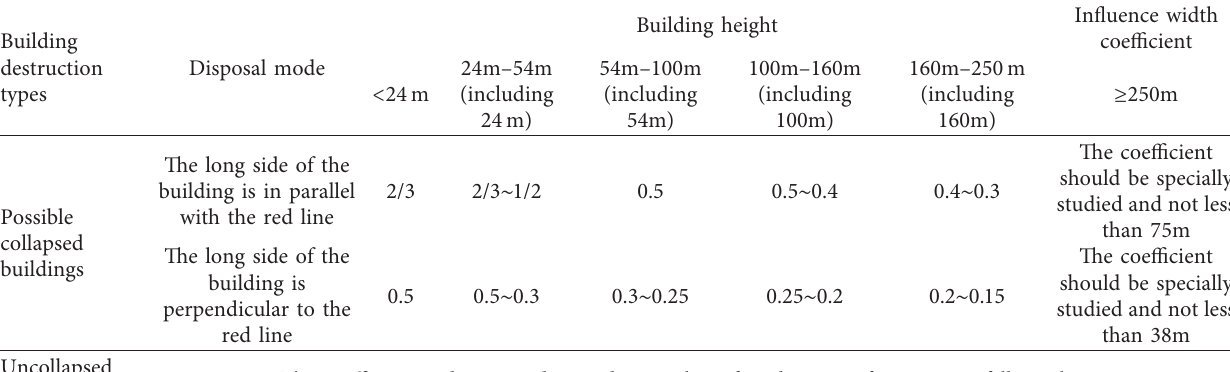
Table 7: Building collapse impact distance simplified calculation